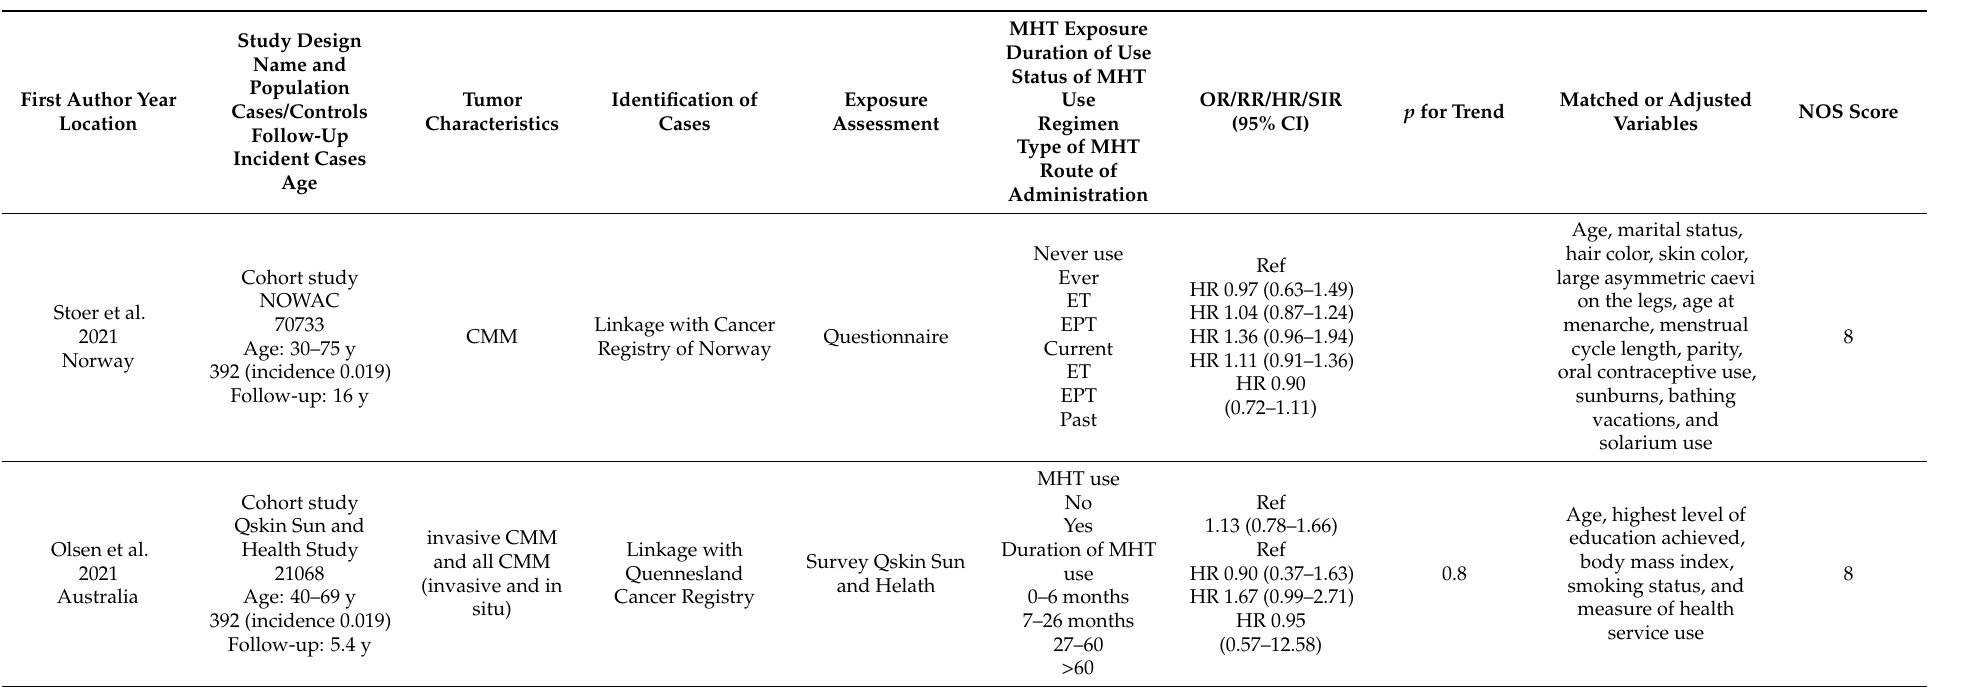
Table A2. Main characteristics of studies included in the systematic review and meta-analysis on menopausal hormone therapy (MHT) and malignant melanoma